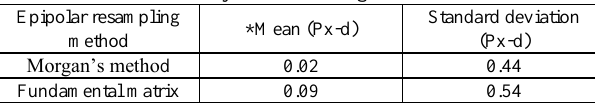
Table 3. Statistical analysis of SGM